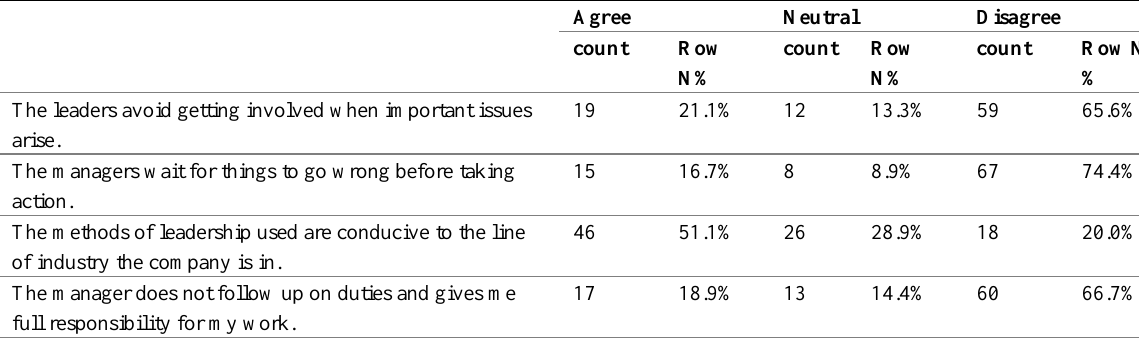
Table 4: Frequency distribution to Laissez-faire leadership style